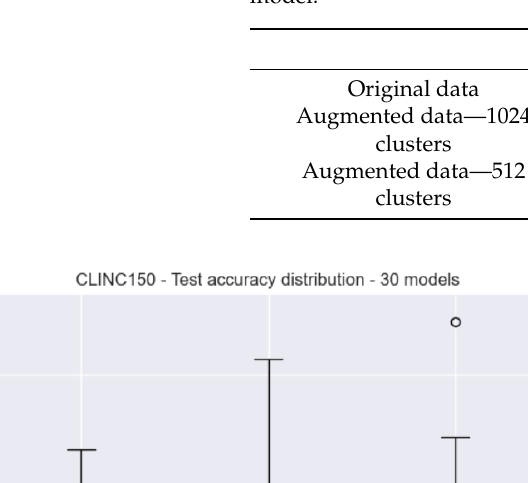
Table 4. Mean accuracy and standard deviation for the first augmentation method, in which a pre- trained classifier is used for classifying additional examples. Bold text denotes the best performing model.